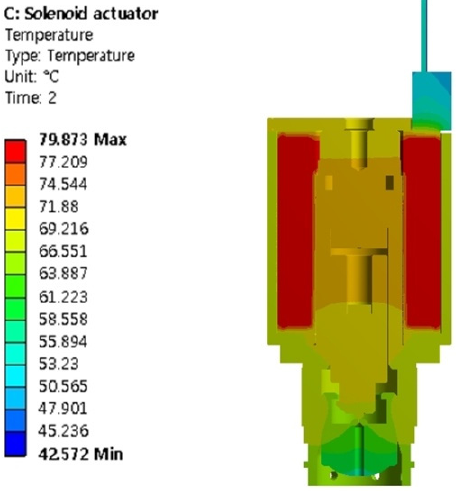
Figure 9. Thermal analysis results.